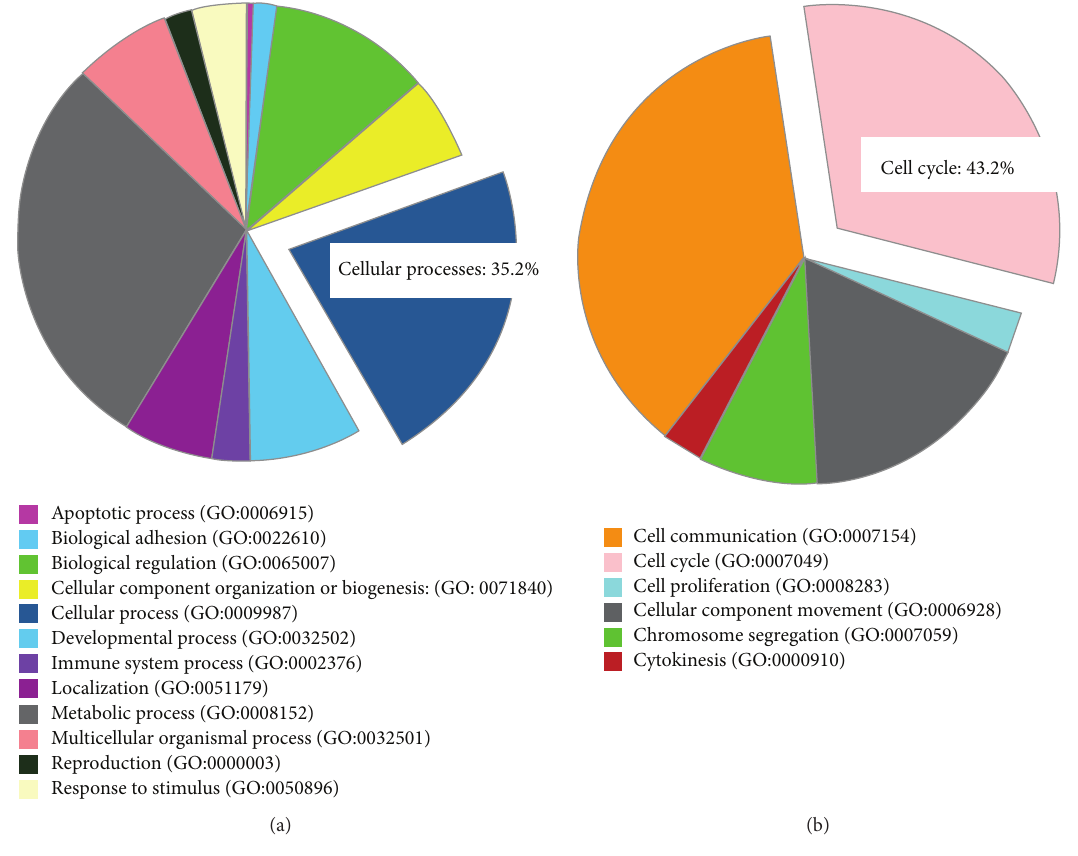
Figure 1: Overexpression of Nr4a1 and Nr4a3 results in upregulation of a subset of cell cycle genes unregulated by Nkx6.1. Previous published microarrays of Nr4a1, Nr4a3, or Nkx6.1 overexpressed in primary rat islets were compared for genes induced by Nr4a1 and Nr4a3 but not induced by Nkx6.1. (a) Using Panther pathway analysis (pantherdb.org), 114 genes were found to be upregulated by Nr4a1 and Nr4a3 but not by Nkx6.1, of which 35.2% were found to be involved in the GO category cellular processes. (b) Within the GO category cellular processes, 43.2% of the genes (17 genes) were found to be associated with the GO category cell